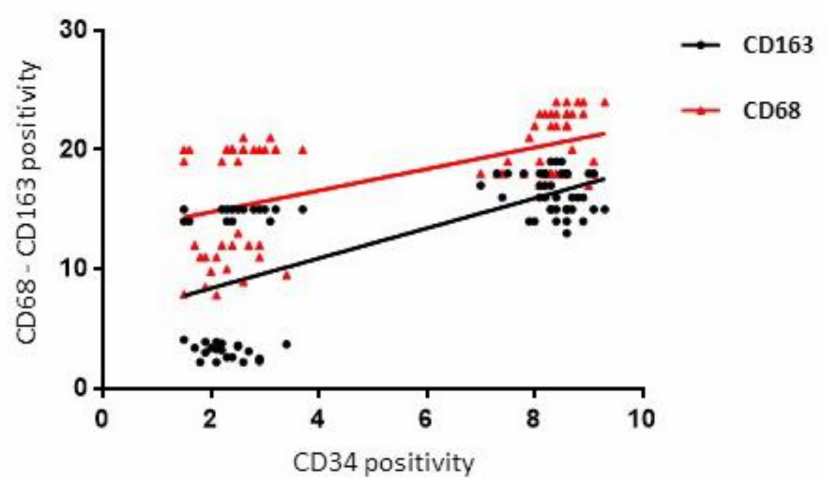
Figure 8. Regression analysis graph indicating the correlation between CD163 and CD34, CD68 and CD34 in FL and CTRL